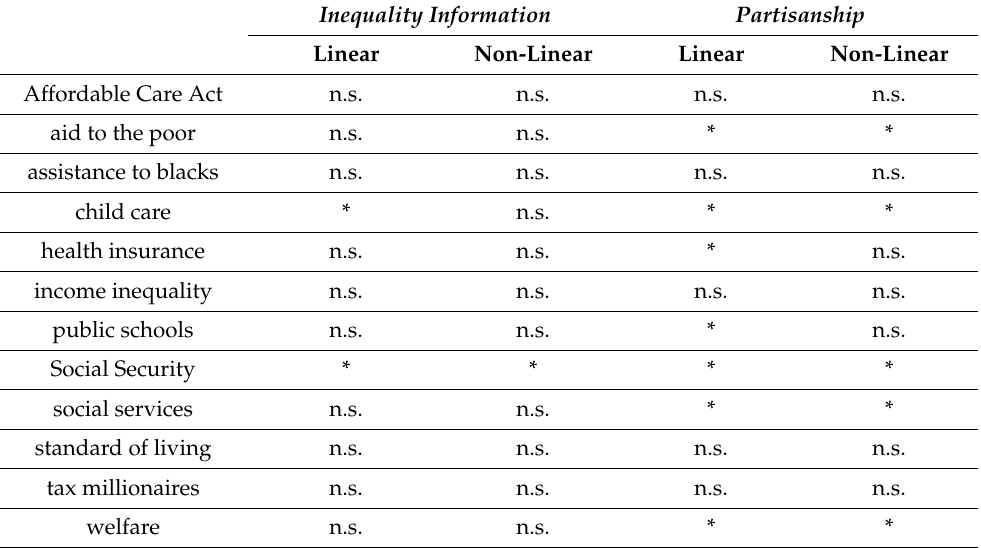
Table 3. Tests for covariate × year interactions a .